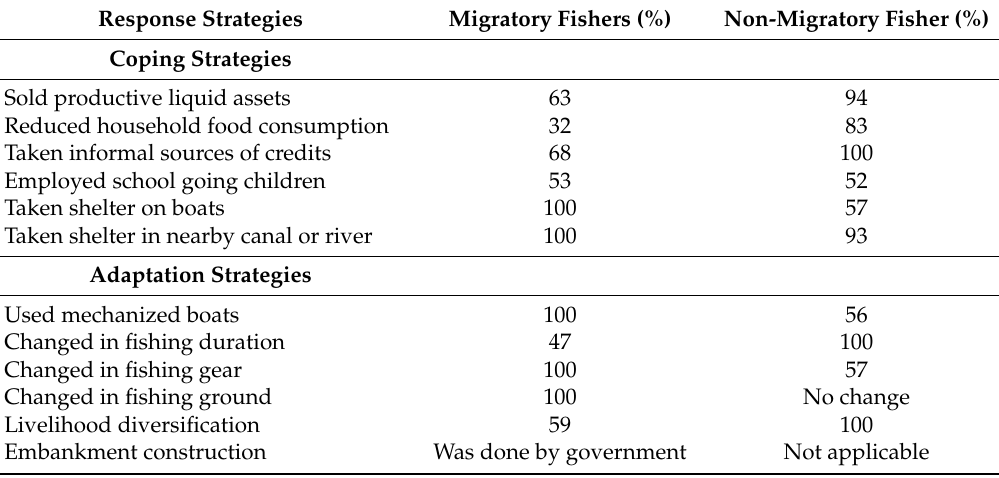
Figure 5. Response strategies (coping and adaptation) to the impacts caused by different hazards by the fishers’ dependent on the Padma River fisheries, Bangladesh. Source: Authors own illustration. Table 4. Percentage of Padma River migratory and non-migratory fishers adopt response strategies to climatic hazards and disasters.